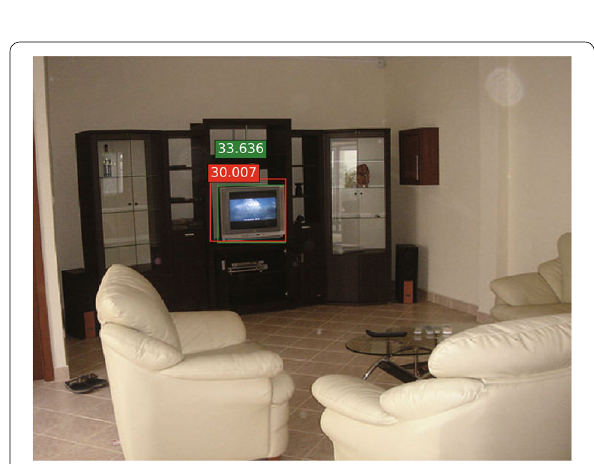
Fig. 11 Examples of results in Pascal3D size TV monitor. The ground truth distance and estimated distance are written in green and red boxes respectively. The unit of distance is based on CAD